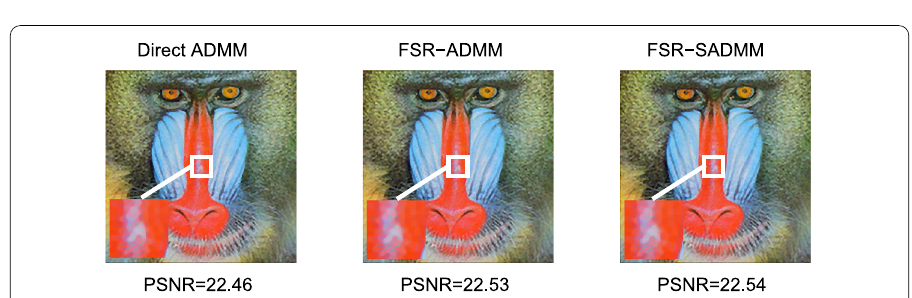
Figure 3 From left to right: super-resolution Baboon by direct ADMM, FSR-ADMM, and FSR-SADMM.